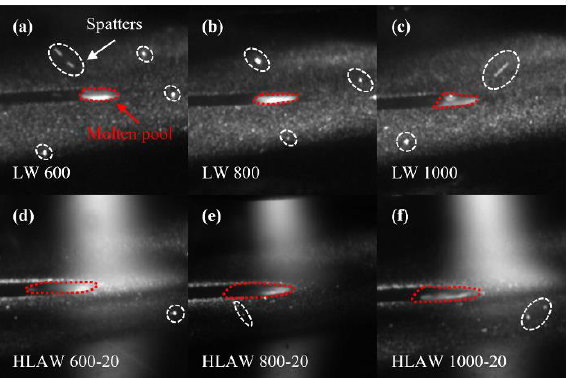
Figure 3. Static picture of welding process under different welding methods: ( a – c ) LW 600, LW 800, and LW 1000, respectively. ( d – f ) HLAW 600-20, HLAW 800-20, and HLAW 1000-20, respectively.